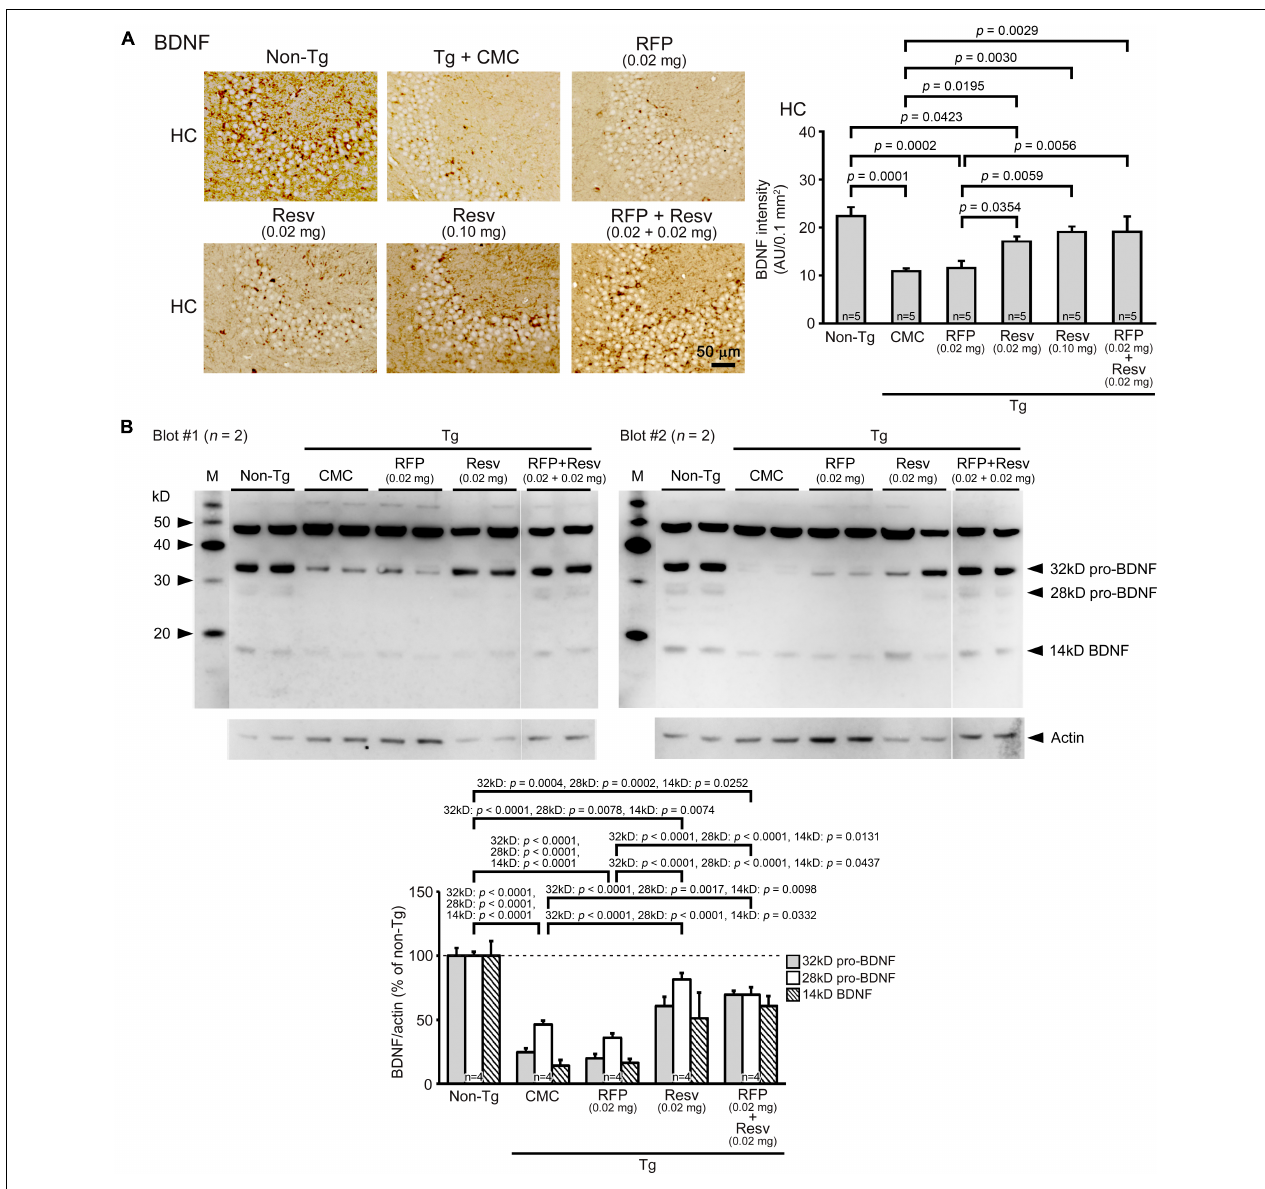
FIGURE 2 | Effects of intranasal rifampicin and resveratrol combination on BDNF levels in APP OSK mice. (A) Brain sections were stained with an anti-BDNF antibody. The level of BDNF in the hippocampal CA2/3 region was decreased in Tg mice. Resveratrol (Resv) alone and the combinatorial medicine, but not rifampicin (RFP) alone, recovered the BDNF level. (B) Hippocampal soluble fractions were subjected to western blotting with an antibody for BDNF. The levels of BDNF, pro-BDNF, and truncated pro-BDNF were significantly restored by Resv alone and the combinatorial medicine, but not by RFP alone. CMC, carboxymethylcellulose. M, MagicMark XP Western Protein Standard (Invitrogen, Carlsbad, CA, United States). AU, arbitrary unit. Values represent the mean ±